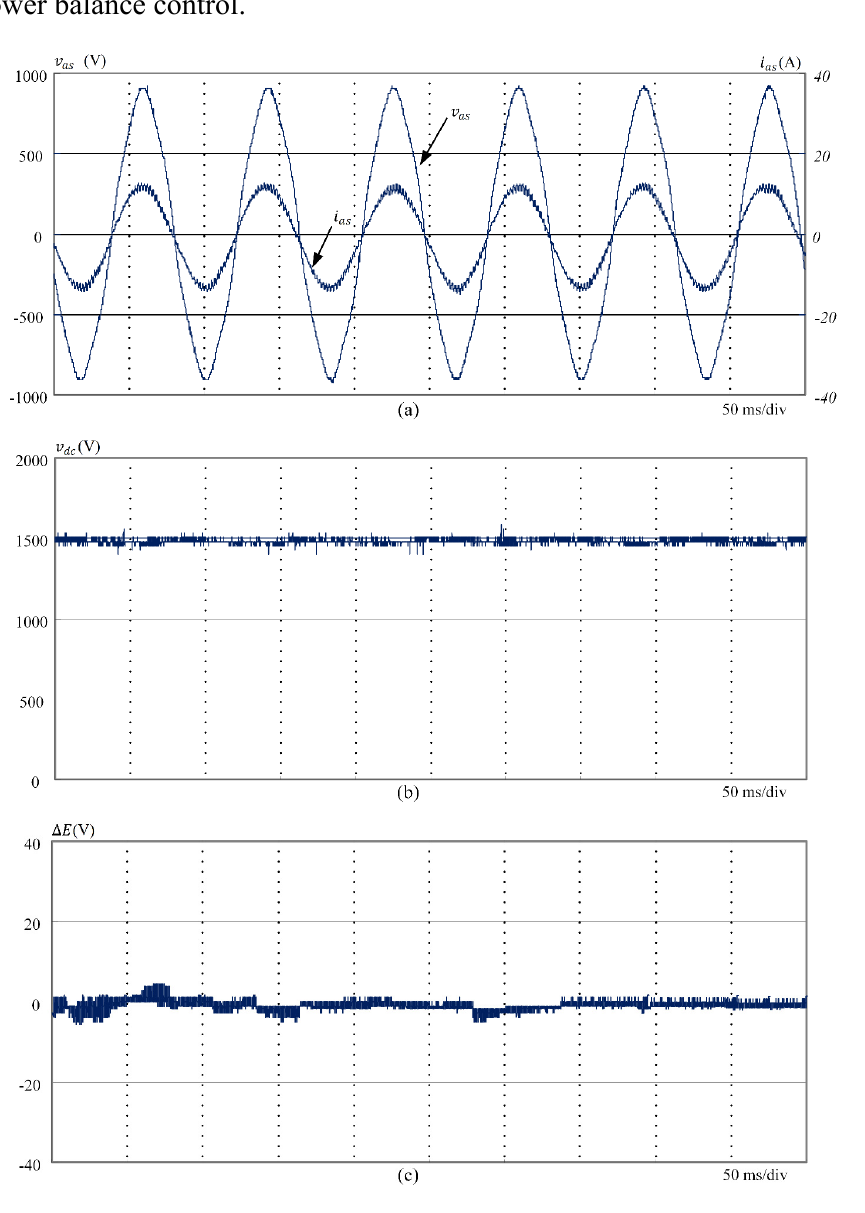
= (cid:1844) = (cid:2869) (cid:2870) ; and ( c ) (cid:3031)(cid:3030)